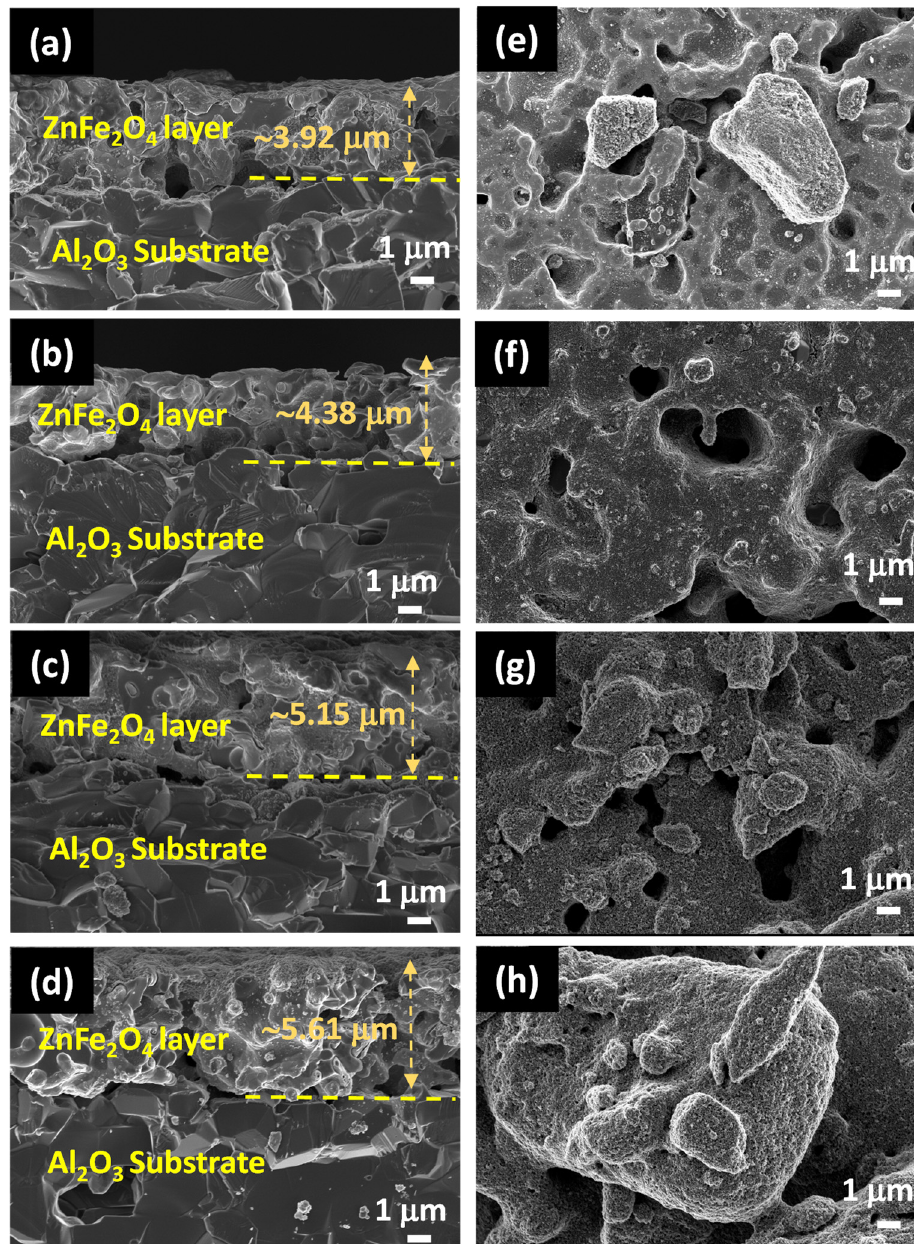
Figure 3. ( a – d ) Cross-sectional images of the ZnFe 2 O 4 deposited sensing films at volumes of 1.0, 1.5, 2.0, and 2.5 µL, respectively, and ( e – h ) the corresponding top view SEM images.